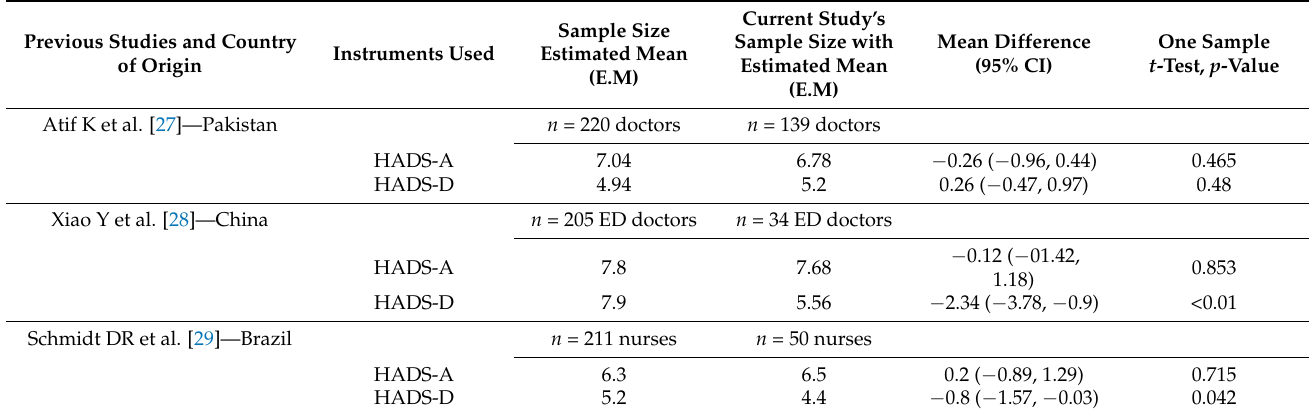
Table 4. Comparison of anxiety and depression amongst Malaysian HCWs with identical studies from other